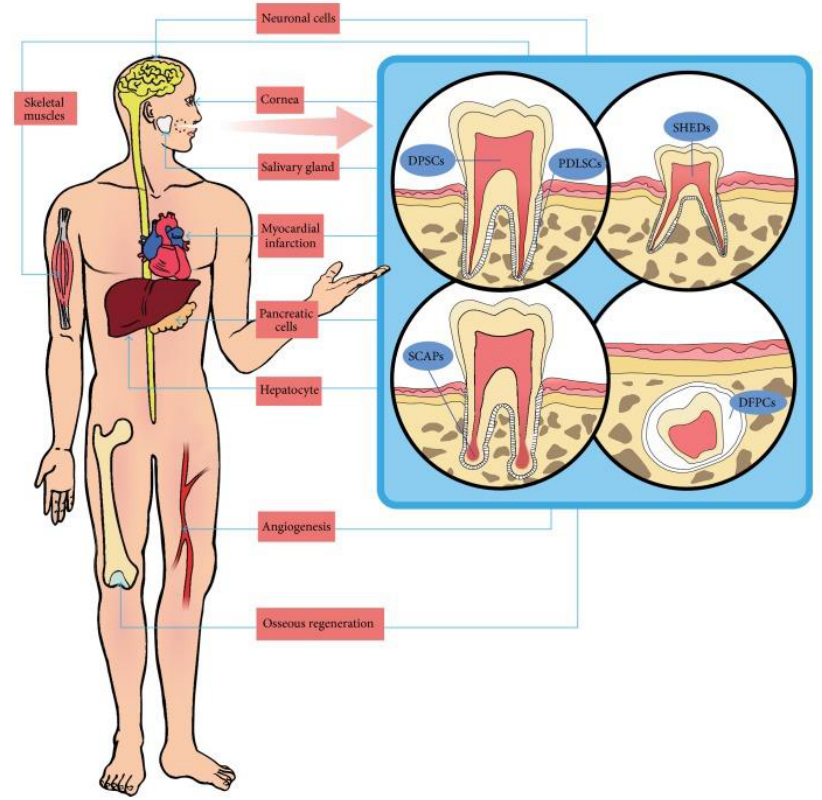
Figure 3. The multipotent potential of dental-derived stem cells. Reprinted/adapted with permission from Park et al. [41] under creative common license.